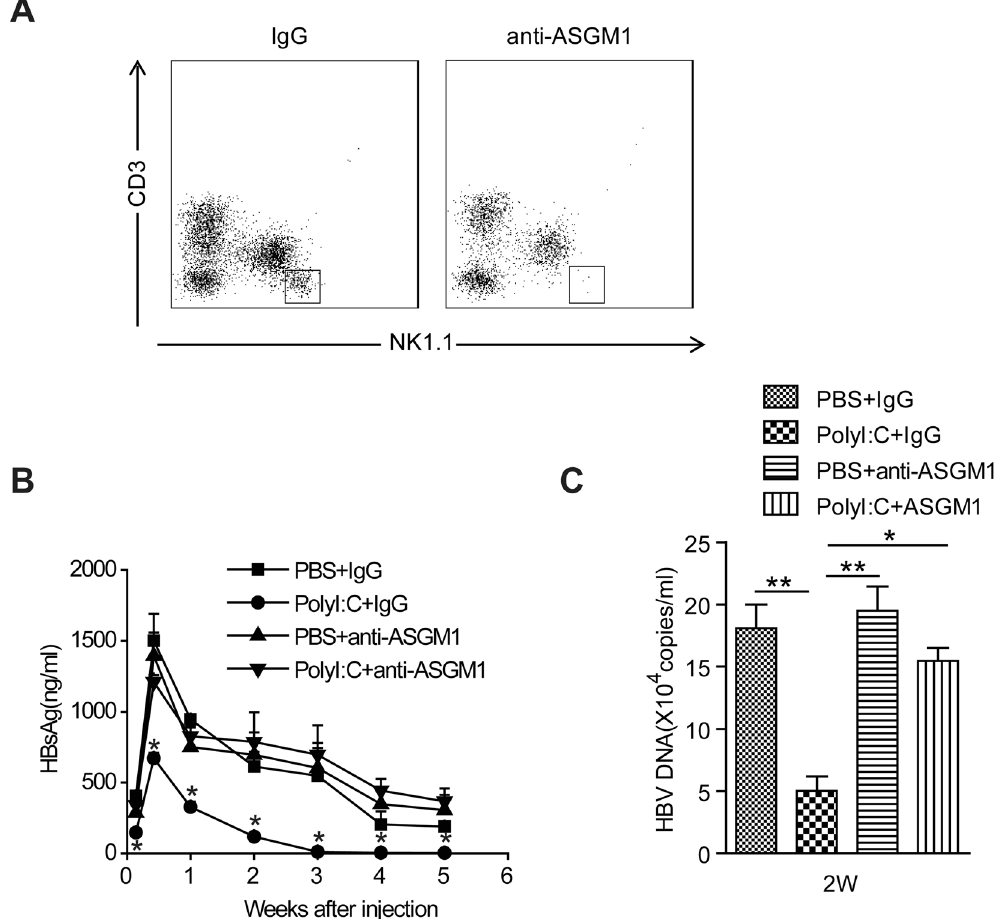
Figure 5. Depletion of NK cells abrogates the anti-HBV activity of PolyI:C. Mice were injected with HBV plasmid and chronically treated with control Ab or anti–ASGM-1 Ab and Poly I:C, as described in Materials and Methods, for 5weeks. ( A ) Depletion of NK cells (NK1.1 + CD3 − ) was confirmed by flow cytometry. ( B ) Titers of serum HBsAg were determined at the indicated time points post injection. * p < 0.05 vs. PBS + IgG group or PBS + anti–ASGM-1 group or Poly I:C + anti–ASGM-1 group. ( C ) Titers of serum HBV DNA copies were determined at 2 weeks post injection. Data are shown as mean ± SEM; * p < 0.05, ** p < 0.01. n = 4–6 in each